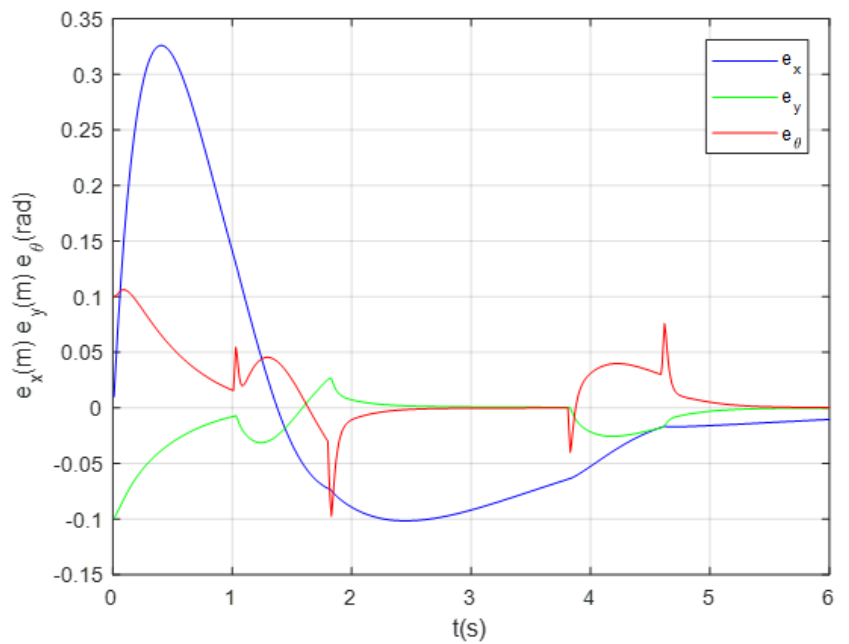
Figure 12. Performance of linear errors e x , e y and angular error e θ in tracking S-curve of working map.